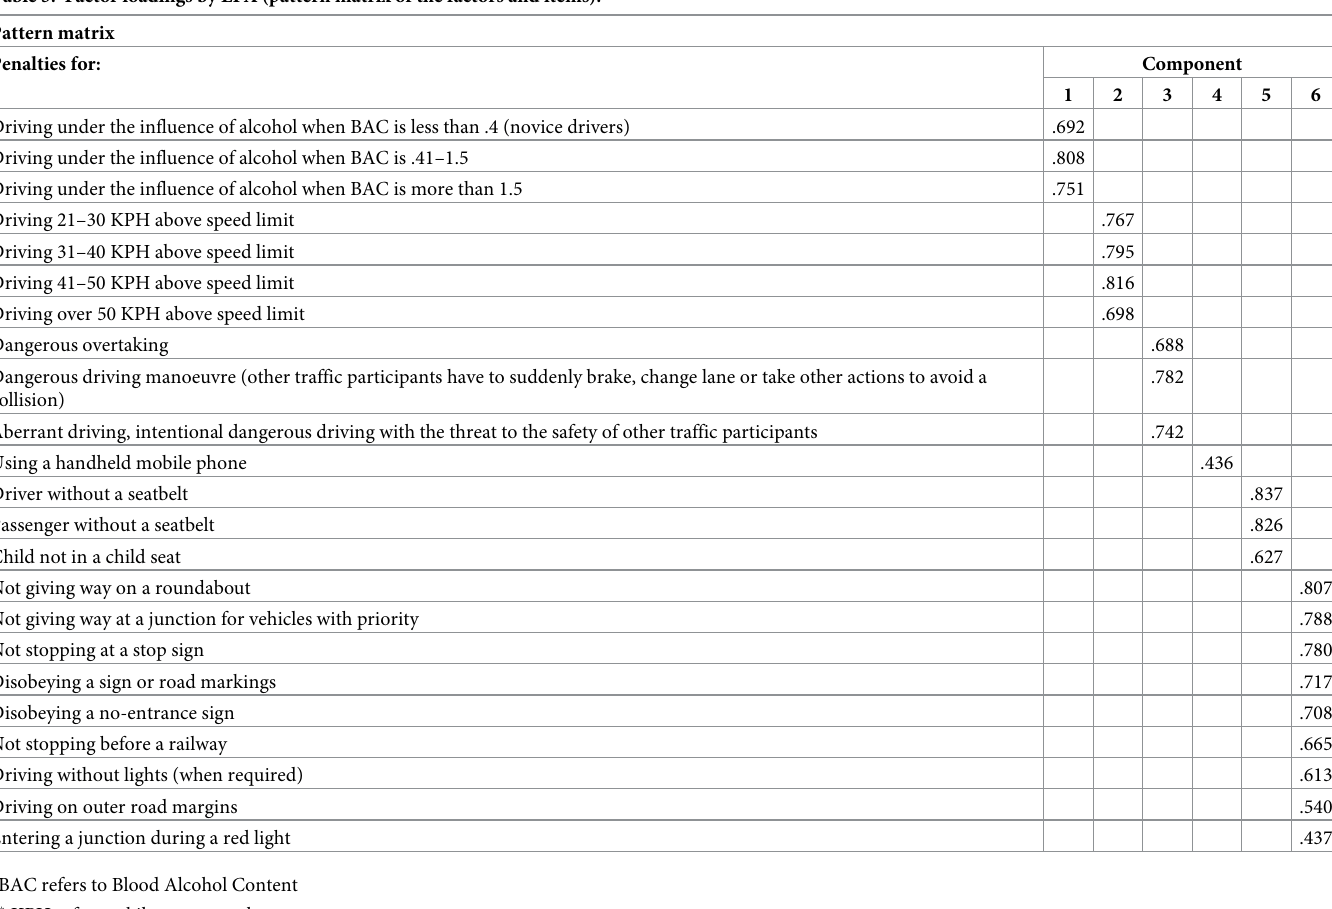
Table 3. Factor loadings by EFA (pattern matrix of the factors and